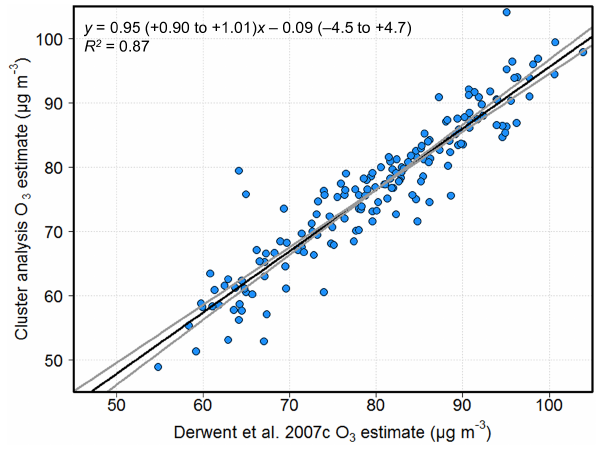
Figure 1. Correlation between monthly hemispheric background O 3 concentrations derived by Derwent at al. (2007c) using pollu- tant tracers and atmospheric modelling to select “clean” air masses, and derived by the method described in Sect. 2.1 using cluster anal- ysis. Black regression line is calculated by the ordinary least squares (OLS) method, with confidence intervals (95th percentile) shown in